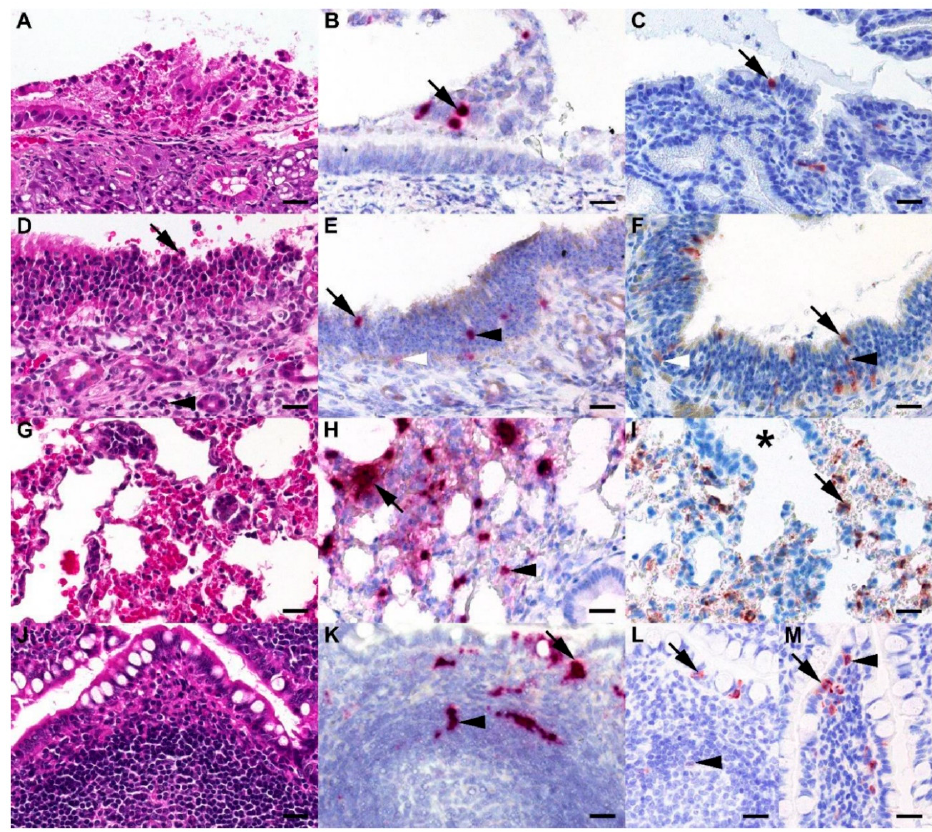
Figure 2. Histologic lesions exhibit H18-specific RNA signals and IAV-matrix protein immunoreactivity in the upper and lower respiratory tract of H18N11-infected Seba’s short-tailed bat ( Carollia perspicillata ) at 4 dpi. ( A ) Bat, rostral nose. Mild, focal, acute, necrotizing rhinitis with erosion of the respiratory epithelium and sloughing of cells. ( B ) Bat, rostral nose. Oligofocal single H18-specific RNA signals in luminal debris (arrow). ( C ) Bat, rostral nose. Oligofocal strong intracytoplasmic and intranuclear IAV-matrix protein immunoreactive respiratory epithelial cells (arrow). ( D ) Bat, caudal nose. Mild, focal, acute, necrotizing rhinitis with pyknotic cells (arrow) and mild multifocal infiltration of neutrophils (arrowhead) in the Bowman’s glands rich lamina propria. ( E , F ) Bat, caudal nose. Oligofocal H18-specific RNA signals and strong intracytoplasmic and intranuclear IAV-matrix protein immunoreactive cells interpreted as sustentecular cells (black arrow), olfactory receptor neurons (black arrowhead) and basal cells (white arrowhead). ( G ) Bat, right cranial lung lobe. Normal appearing lung tissue with alveolar spaces. ( H ) Bat, right cranial lung lobe. Multifocal H18-specific RNA signals in intra-alveolar cellular clusters (arrow) and in single cells (arrowhead). ( I ) Multifocal strong IAV-matrix protein reactive cells (arrow) in areas associated with respiratory bronchioles (asterisk). ( J ) Bat, jejunal Peyer’s patch (JPP). Follicle-associated epithelium (FAE) and a lymphocyte-rich subepithelial dome region of a normal appearing JPP is depicted. ( K ) Bat, JPP. Multifocal H18-specific RNA signals are seen in FAE (arrow) and in the subepithelial dome regions (arrowhead). ( L ) Bat, JPP. Oligofocal strong intracytoplasmic IAV-matrix protein immunoreactive cells are seen in the FAE (arrow) and faintly intracytoplasmic reactive cells next to a germinal center (arrowhead). ( M ) Bat, jujunal villus. Oligofocal strong intracytoplasmic and intranuclear IAV-matrix protein immunoreactive enterocytes (arrow) and lamina propria associated round cells interpreted as macrophages or dendritic cells (arrowhead) were evident. A, D, G, J, Hematoxylin eosin stain; B, E, H, K, in situ hybridization, target retrival and protease pretreatment, RNAscope ® 2.5 assay H18-specific RNA, Fast Red chromogen (red), hematoxylin counterstain (blue), C, F, I, L, M IAV-matrix protein immunohistochemistry, avidin-biotin-peroxidase complex method with 3-amino-9-ethyl-carbazol as chromogen and hematoxylin counterstain; bars, A–M = 20 µ